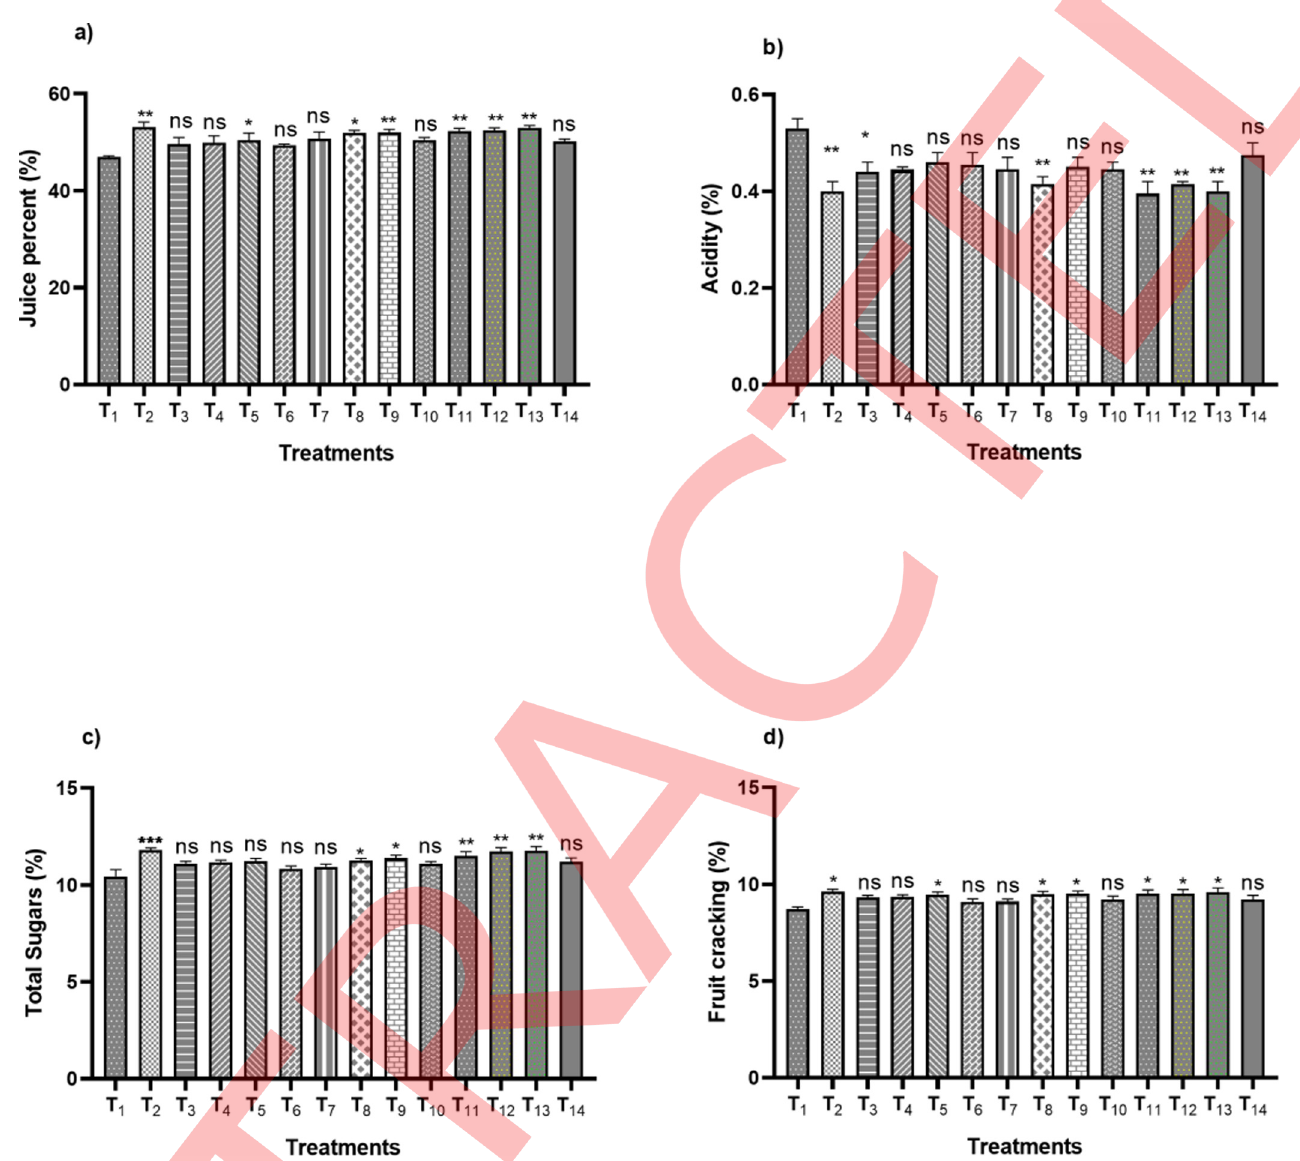
Fig 5. The effect of different organic manure treatments on soil chemical properties, where ( a ) Juice percent; ( b ) Acidity percent; ( c ) Total sugars percent; d) Fruit cracking percent. Various asterisk on bars show the significant differences ( P < 0.05) with vertical bars as standard errors ( n = 4) ( ���� > ��� > �� > � >